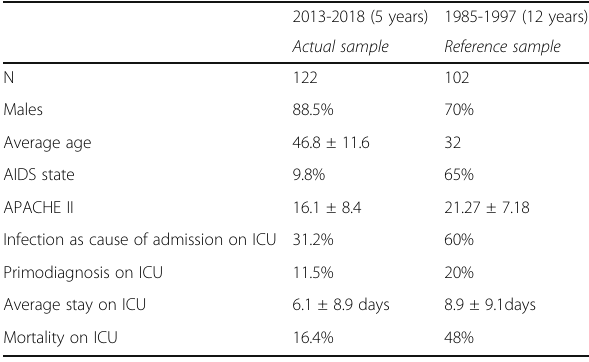
Table 1 (abstract 001476). See text for